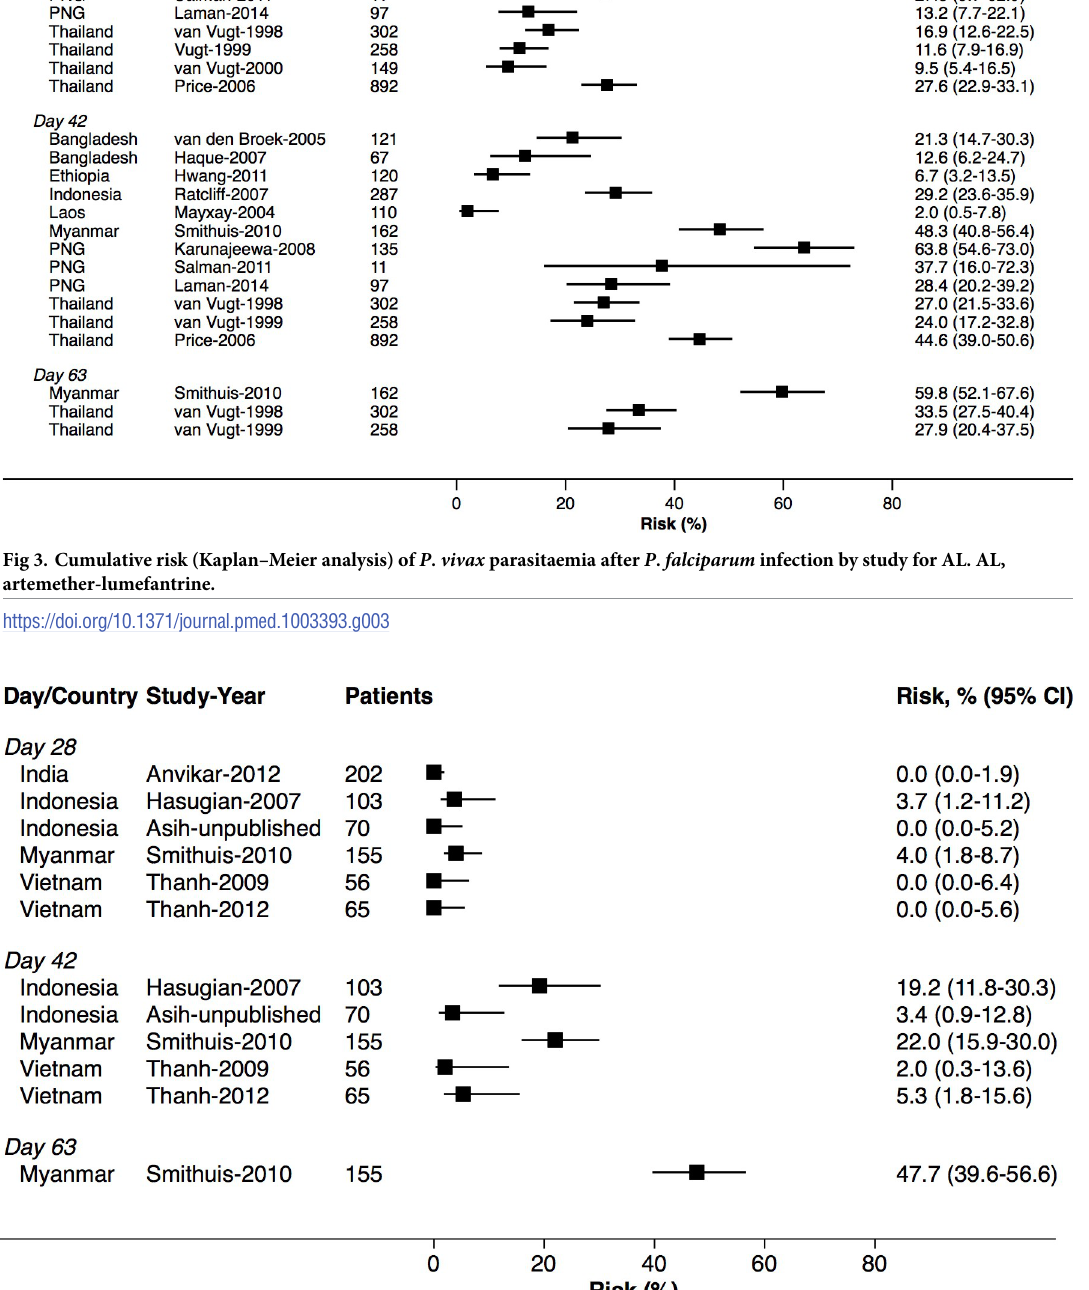
PLOS Medicine| https://doi.org/10.1371/journal.pmed.1003393 November19,